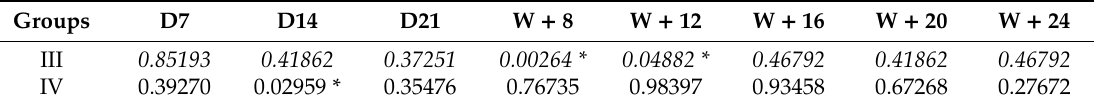
Table 4. The prostate volume changes (V, cm 3 ) in both Study Groups III and IV. Significance level in relation to D0: probability ( p